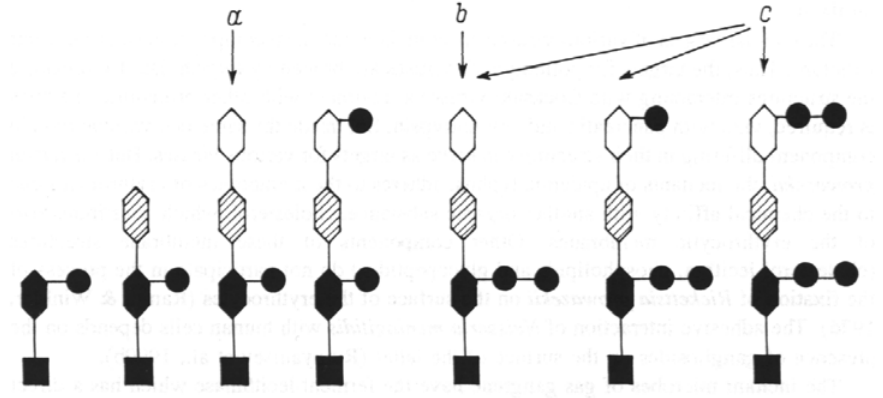
FIGURE. 5 . Dependence of organism’s vulnerability by microbial agents on the presence of gangliosides (1-7) in cell membranes. (a) Choleraic, (b) botulinic, and (c) tetanic